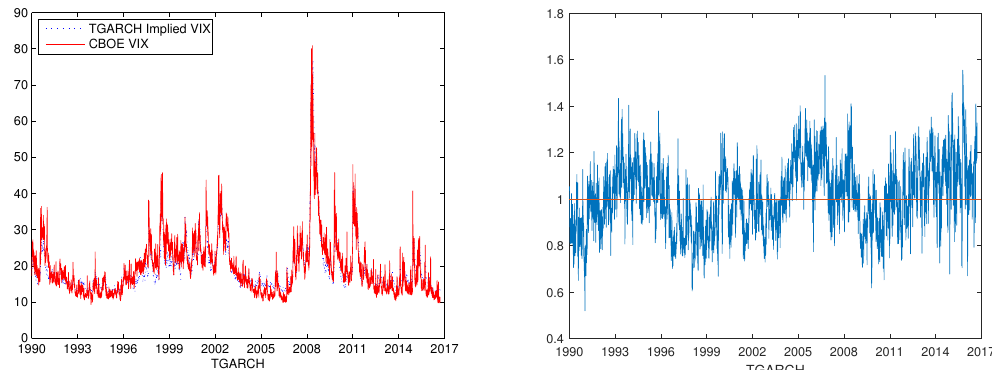
Figure 4. Comparison between CBOE VIX and implied VIX of the TGARCH(1,1) model using VIX data only. The left panel shows the index values of CBOE VIX and implied VIX and the right panel shows the ratio of the implied VIX to CBOE VIX and a horizontal line at 1 for reference.